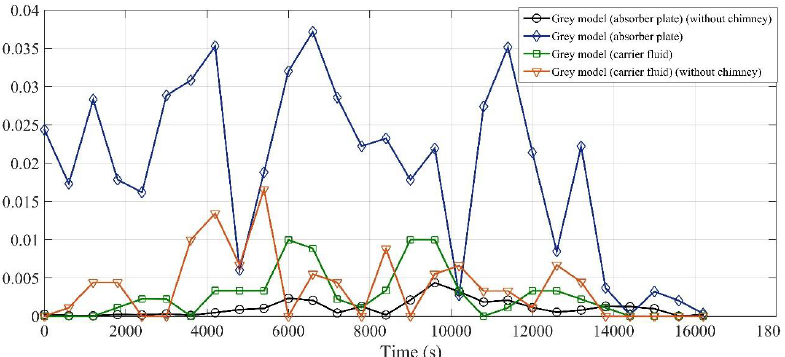
Figure 10. Variation in mean absolute percentage error (MAPE(T)) of the models to forecast temper- ature pattern of absorber plate and air. The complied average values of discussed parameters are provided in Table 4. The average value of stream function estimated through the nonlinear grey model dropped by 2.56% as compared to the Blasius solution. The vertical component of mainstream ve- locity ( v ) reduced by 9.90% while simulating it with the nonlinear grey model for a non- conventional system. In the case of the conventional system, the margin of percentage drop in the vertical component of velocity was reduced by 40.60%. The average shear stress experienced by the conventional unit was remarkably reduced by 88% while using the proposed nonlinear grey model, whereas it was estimated to be diminished by 81.80% when the same parameters were computed through the analytical model. Table 4. Parametric information about the grey and analytical models. Parameters